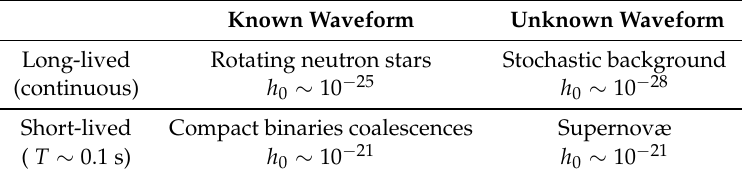
Table 1: continuous gravitational waves (CGWs), subject to this review; stochastic background GW which is a mixture of a large number of independent sources; inspirals and mergers of binary systems; burst sources e.g., supernovæ explosions or magnetar flares. Search strategies for each type depend on the duration of GWs emission, knowledge of the signal model, characteristic amplitudes of the GWs, and the computational resources. Table 1. General taxonomy of GWs sources and their expected GW strain order-of-magnitude amplitude h 0 . Known